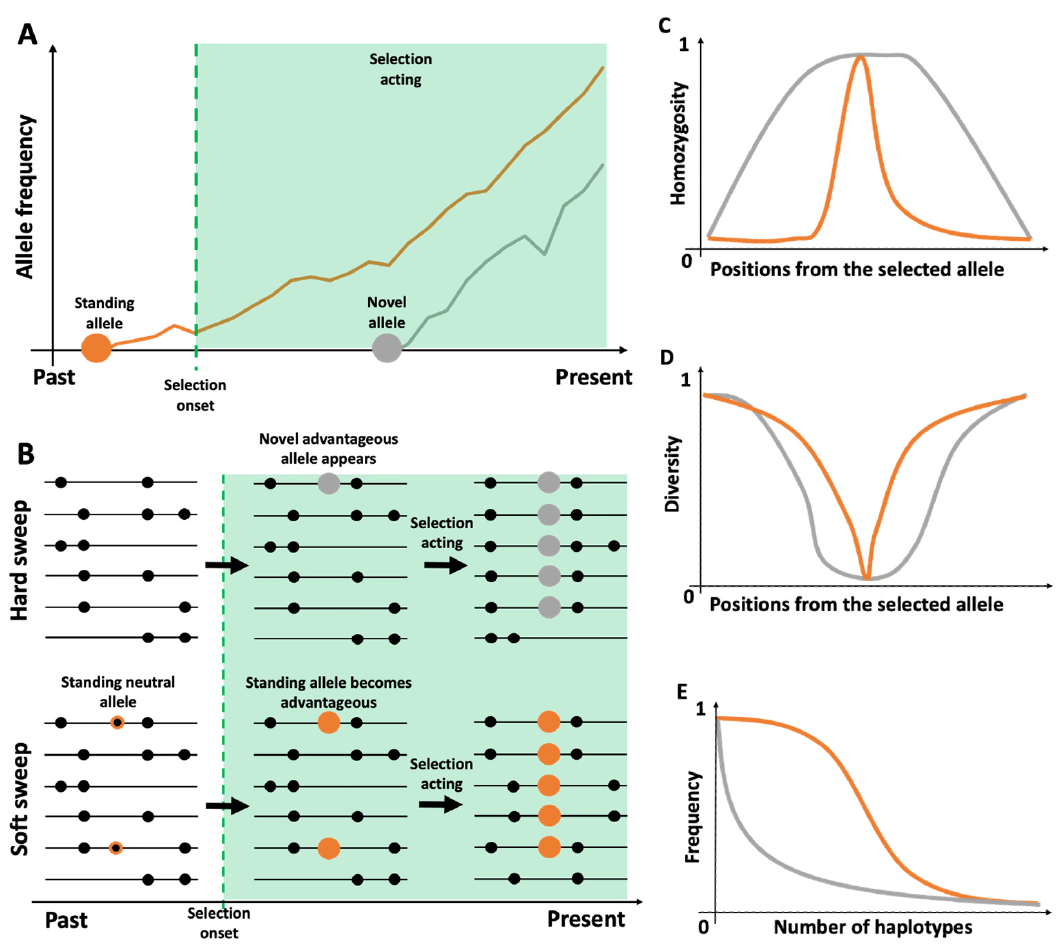
Figure 1. Effect of selection of standing and novel alleles. ( A ) A novel allele, in grey, appears after selection has begun its action and is immediately beneficial, so it will rapidly increase its frequency in the population over time; a standing allele, in orange, already exists in the population as a neutral allele with relatively low frequency, and it increases after becoming beneficial. ( B ) Representation of a hard and a soft sweep, relative to the conditions described for panel A. ( C ) Variation in the pattern of haplotype homozygosity in a region surrounding a central ancestral (orange) or derived (grey) allele under selection. ( D ) Variation in the pattern of haplotype composition in a region surrounding a central ancestral (orange) or derived (grey) allele under selection. ( E ) Decrease in the frequency of each most frequent haplotype, given an increasing number of haplotypes surrounding a standing (orange) or novel (grey) positively selected allele in the population.